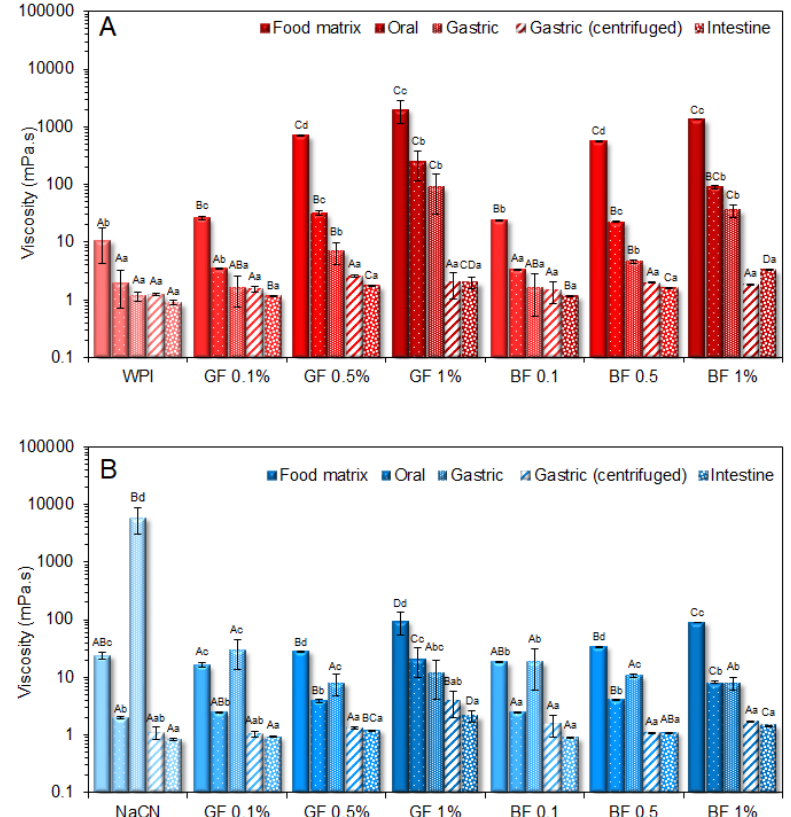
Figure 1. Impact of the golden (GF) and brown (BF) flaxseed gums (FG) on the apparent viscosities of the whey protein isolate (WPI)( A ) and sodium caseinate (NaCN)( B ) -based food models and the oral, gastric, and intestine phases obtained. The term “gastric centrifuged” refers to the samples obtained following centrifugation of the gastric chymes at 4500g for 5 min. a−d, A−D Different letters between the bars denote a significant difference among the samples differing in FG content and phenotype (uppercase) or in vitro digestion step (lowercase).